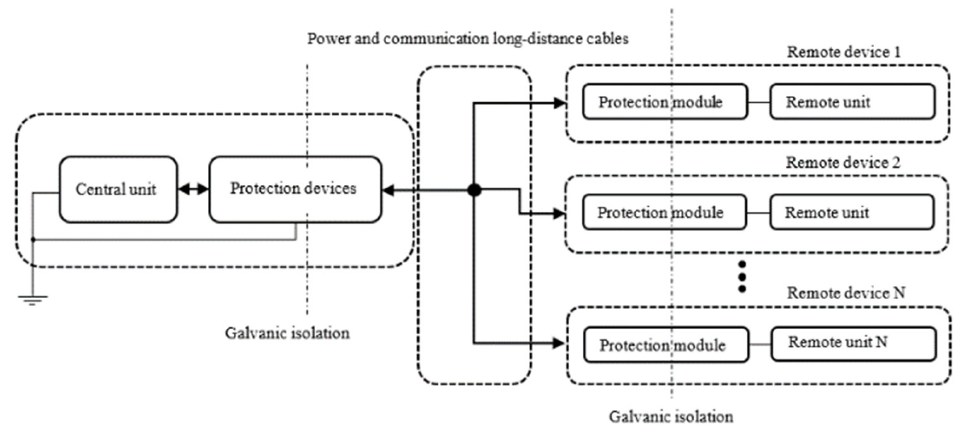
Figure 1. Communication lines topology